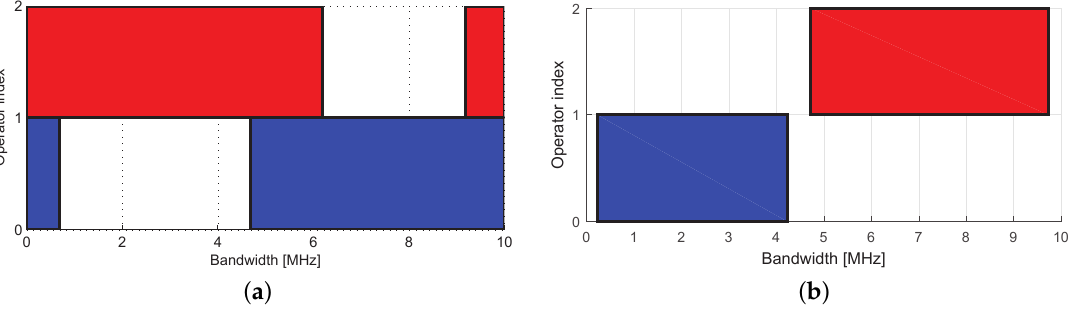
Figure 4. Example of spectrum allocation at an instance of time for two different network operator that signal information related to a spectrum request. In this example the two network operators share a spectrum bandwidth of a size equal to 10 MHz. In case ( a ), which shows an example of non-exclusive spectrum allocation, the two network operators have a spectrum bandwidth request of 6 and 7 MHz. In case ( b ), which shows an example of exclusive spectrum allocation, the two network operators have a spectrum bandwidth request of 4 and 5 MHz, respectively. ( a ) Non-exclusive spectrum